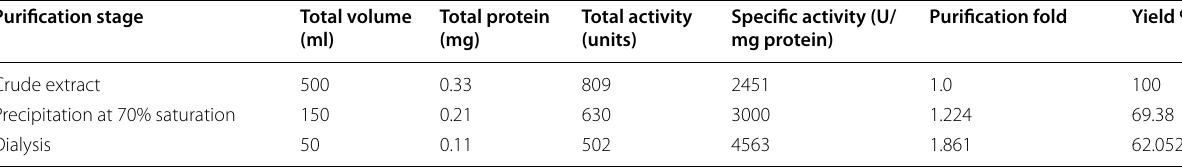
Table 3 Partial purification of tyrosinase by ammonium